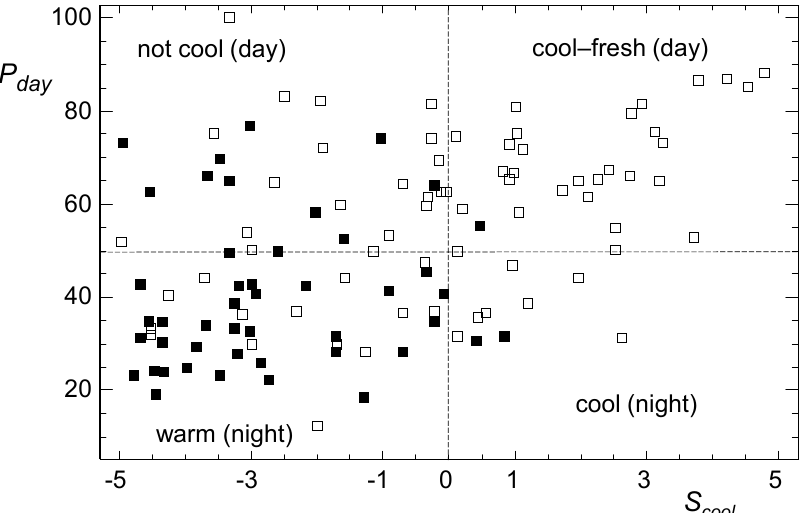
Figure 5. Scatterplot of preference for daytime wear according to Fragrantica ( P day ) versus cool scores ( S cool : sensory ratings on a scale from –5 (warm) to 5 (cool) obtained by Jellinek [14,25] from a panel) for 116 fragrances. Filled points: fragrances described as “sweet” in the H&R guide or classified as “oriental”, “woody–oriental”, “soft–oriental”, or “floral–oriental” by Edwards [12] (fragrances that do not fulfil this criterion appear as unfilled points). Dashed lines were drawn for clarity purposes to divide the scatterplot in four meaningful sections.